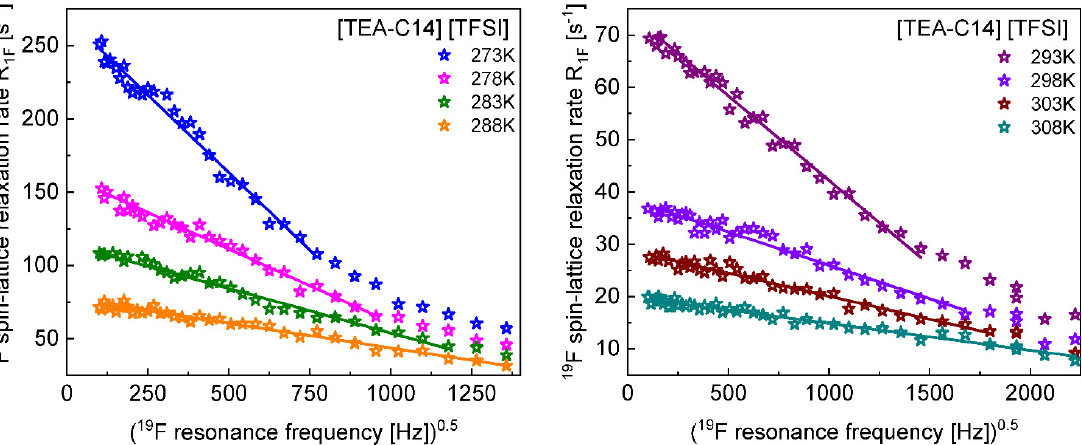
Int. J. Mol. Sci. 2022 , 23 , x FOR PEER REVIEW 14 of 15 Figure A4. 19 F spin-lattice relaxation data for [TEA − C14] [TFSI] versus the squared root of the reso- Figure A4. 19 F spin-lattice relaxation data for [TEA − C14] [TFSI] versus the squared root of the reso- Figure A4. 19 F spin-lattice relaxation data for [TEA–C14] [TFSI] versus the squared root of the nance frequency; solid lines represent linear fits in the low frequency range. nance frequency; solid lines represent linear fits in the low frequency range. resonance frequency; solid lines represent linear fits in the low frequency range.